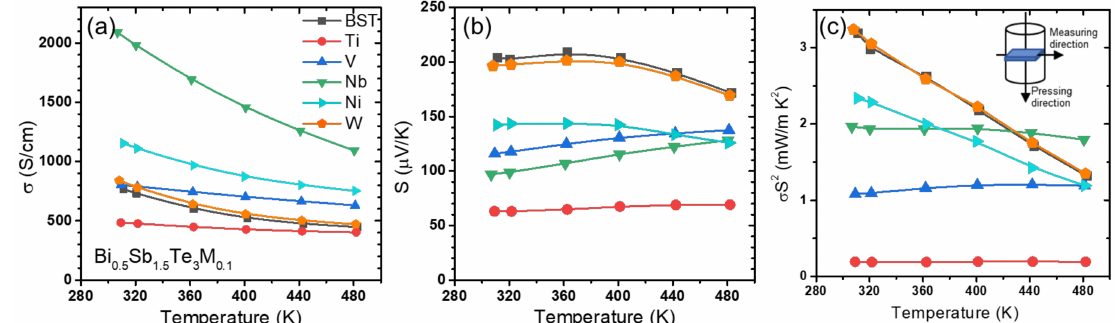
Figure 4. Temperature dependences of the ( a ) electrical conductivity, ( b ) Seebeck coefficient, and ( c ) power factor in Bi 0.5 Sb 1.5 Te 3 M 0.1 ( M = Ti, V, Nb, Mo and